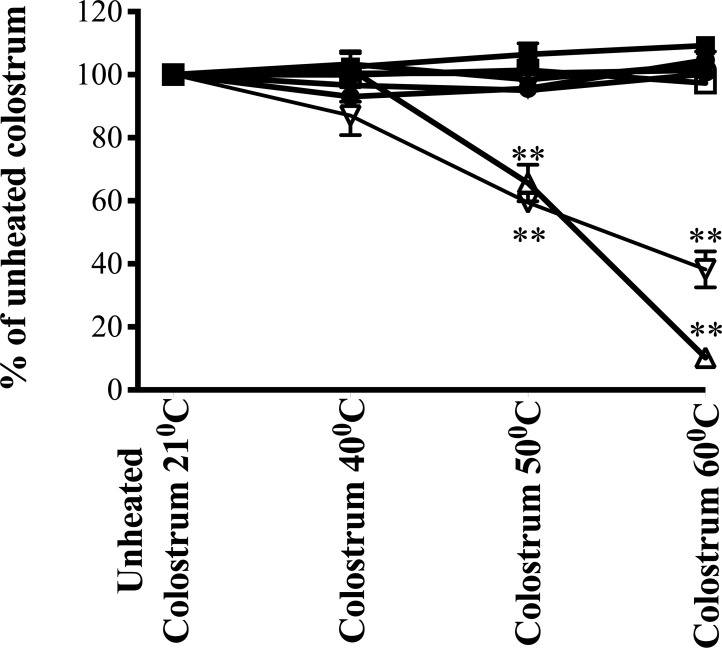
Effect of heating on colostral proliferative and migratory activity and growth factor immunoreactivity.Three 5g samples of sample 9 (from Fig 1A) were heated for 1 h at 40, 50 or 60°C and the fourth kept at laboratory room temperature (21°C, control) throughout. Samples were diluted to 1 mg powder/ml and effects on proliferation (△), cell migration (▽) and growth factor immunoactivity were then determined. In contrast to proliferation and migration results, growth factor immunoreactivity did not change; bovine EGF (▲), bovine TGFβ (▼), bovine haptoglobin (●), bovine betacellulin (◼), and bovine IgG (◯), IGF-1 (☐). Results expressed as % of unheated control, mean +/- SEM of 3 (restitution) or 4 (proliferation and immunoassays) wells per group. ** signifies p< 0.01 vs equivalent bioactivity of unheated (laboratory room temperature) colostrum.